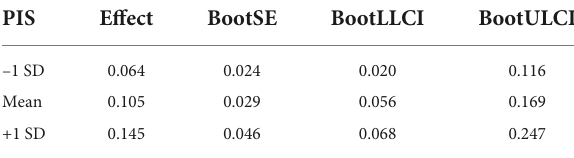
TABLE 6 Results of conditional indirect